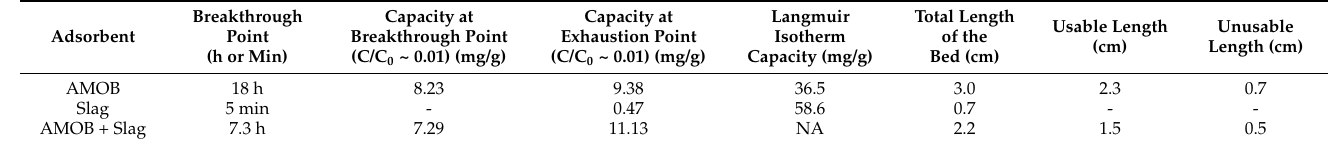
Table 5. Fixed-bed column model predicted data for (a) AMOB, (b) slag, and (c) AMOB +